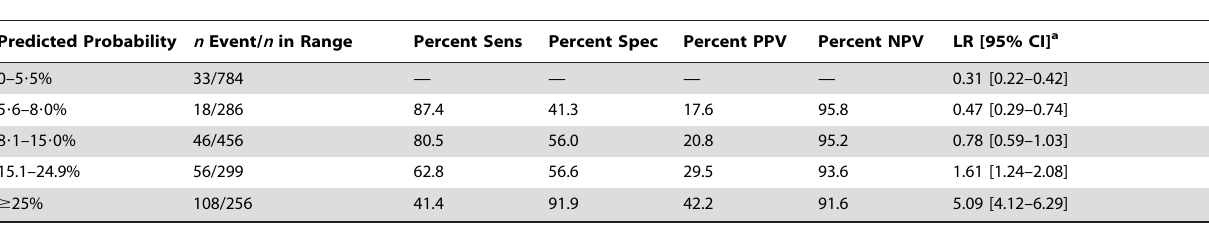
Table 4. Risk stratification table to assess the miniPIERS prediction model.